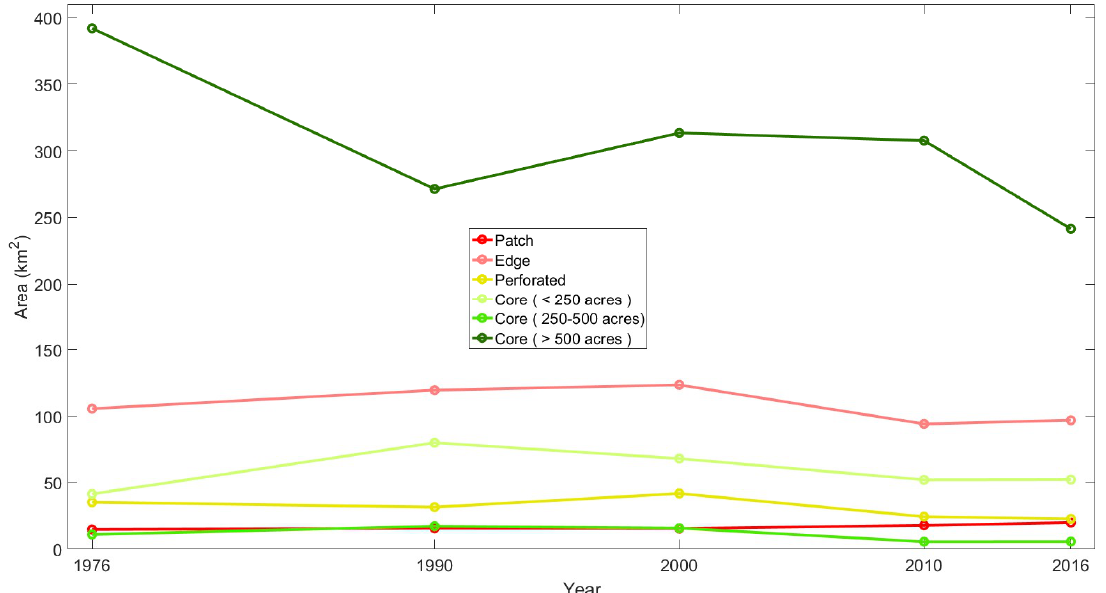
Figure 6. Forest fragmentation graphs for 1976, 1990, 2000, 2010, and 2016.